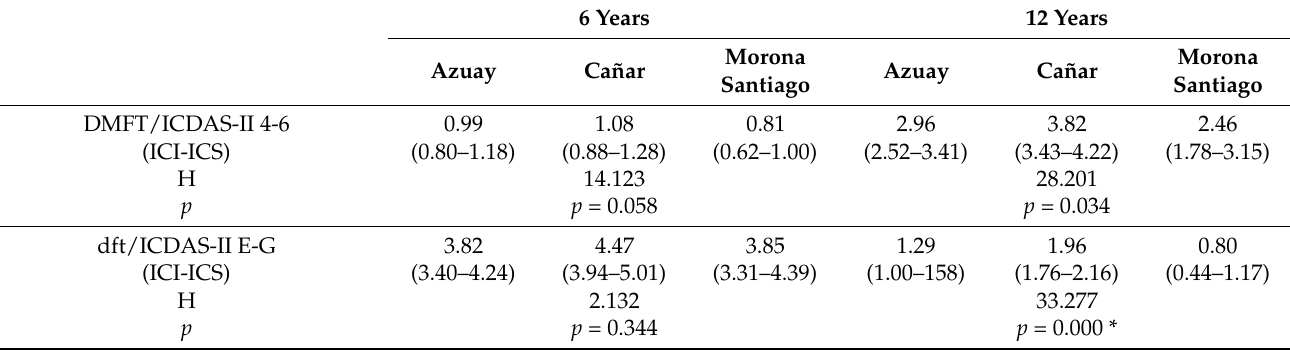
Table 3. Main caries indicators under the ICDAS II 4-6/E-G criteria in each age group according to